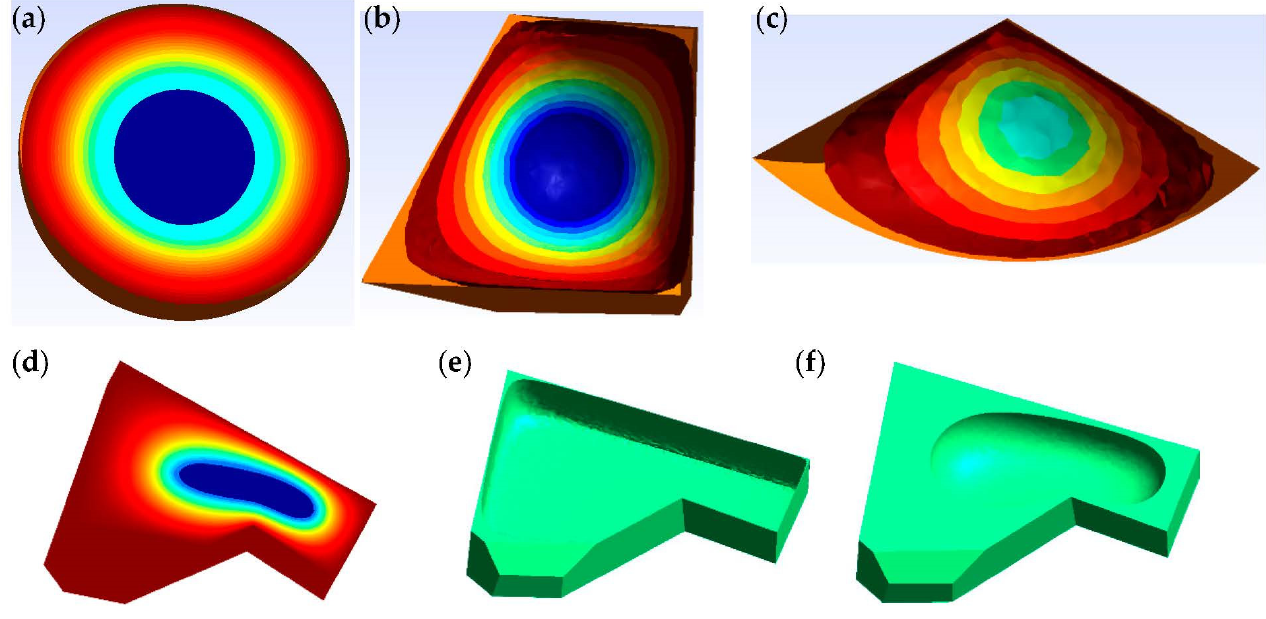
Figure 3. Isosurfaces generated by convex polyhedrons. ( a ) sphere; ( b ) polyhedron; ( c ) section polyhedron; ( d ) concave polyhedron; ( e ) is a pore generated from the 99 isothermal surfaces. ( f ) is a pore generated from the 95 isothermal surfaces. The different color represents different isosurfaces (isothermals).